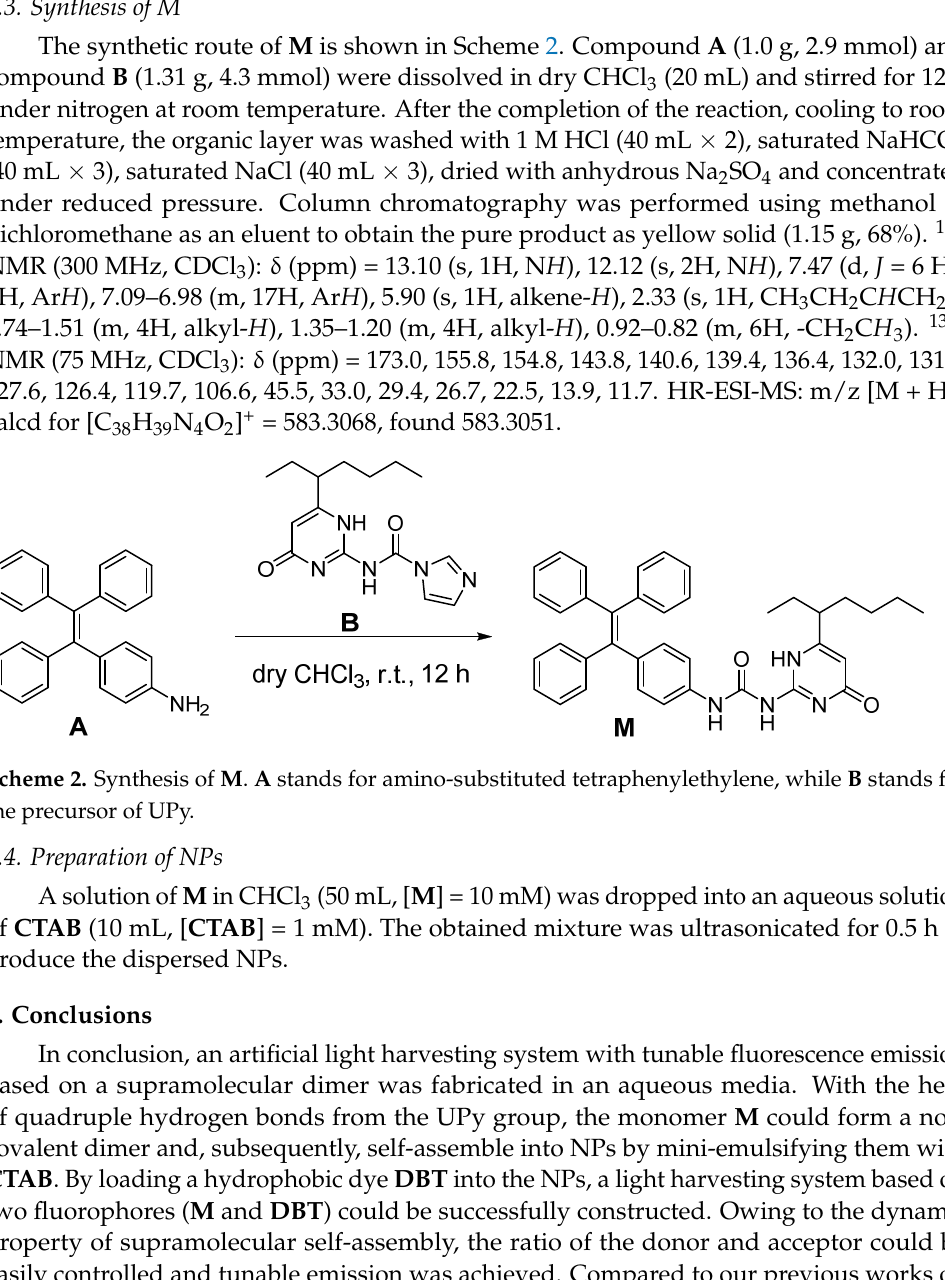
[ DBT ] = 5 × 10 − 7 M, respectively. Figure S5: Fluorescence spectrum of NPs of M and NPs